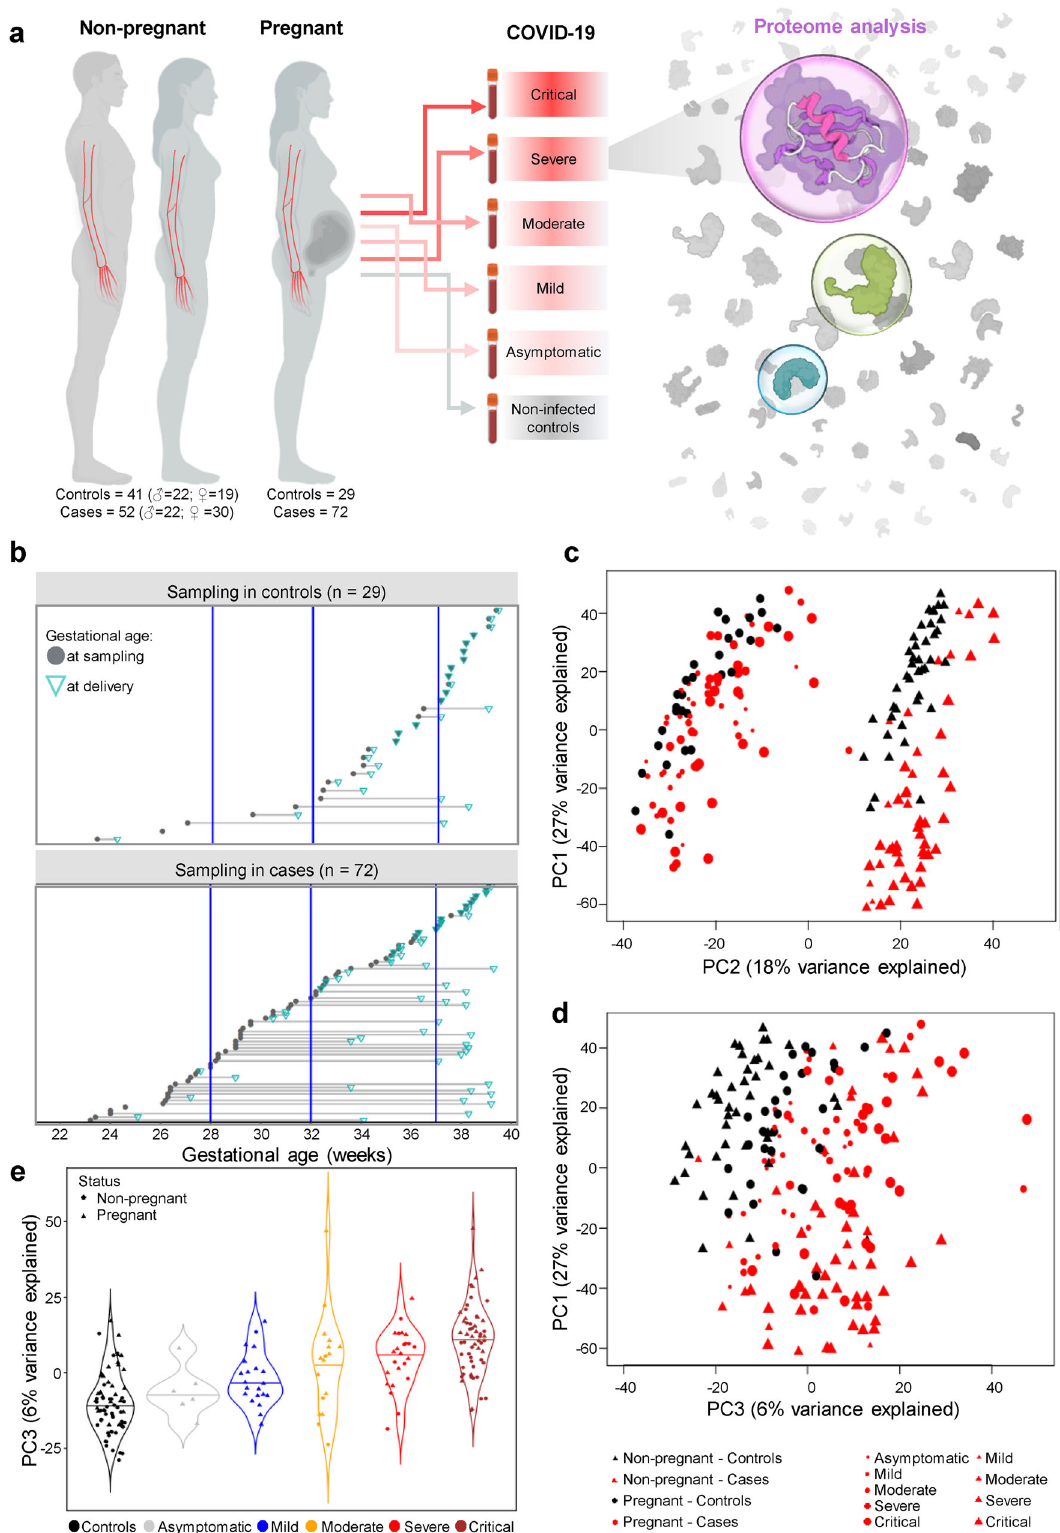
Fig. 1 The plasma proteome of COVID-19 patients differs according to disease severity and pregnancy status. a Illustration of the study design showing the number of non-pregnant controls ( n = 41; 22 male, 19 female), non-pregnant COVID-19 cases ( n = 52; 22 male, 30 female) pregnant controls ( n = 29), and pregnant COVID-19 cases ( n = 72) from whom peripheral plasma samples were pro fi led. b Gestational age at sampling (gray circle) and at delivery (green triangle) for each pregnant control (upper panel) and case (lower panel). c Principal component (PC) plot of the plasma proteome of all study samples according to PC1 and PC2. Black = control, red = case. Circle = non-pregnant, triangle = pregnant. Increasing shape size corresponds to increasing COVID-19 severity. d PC plot representing the relationship between the plasma proteome of all study samples according to PC1 and PC3. e Violin plot representing the relationship between PC3 and COVID-19 severity among all study